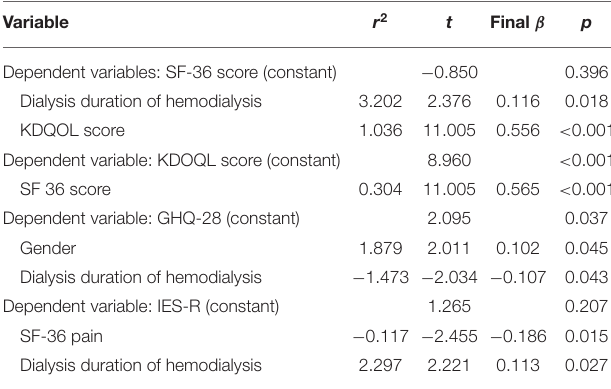
TABLE 5 | Correlation coefficients for the GHQ-28, IES-R, KDQOL, and SF-36 during ongoing COVID-19 pandemic. GHQ-28 IES-R